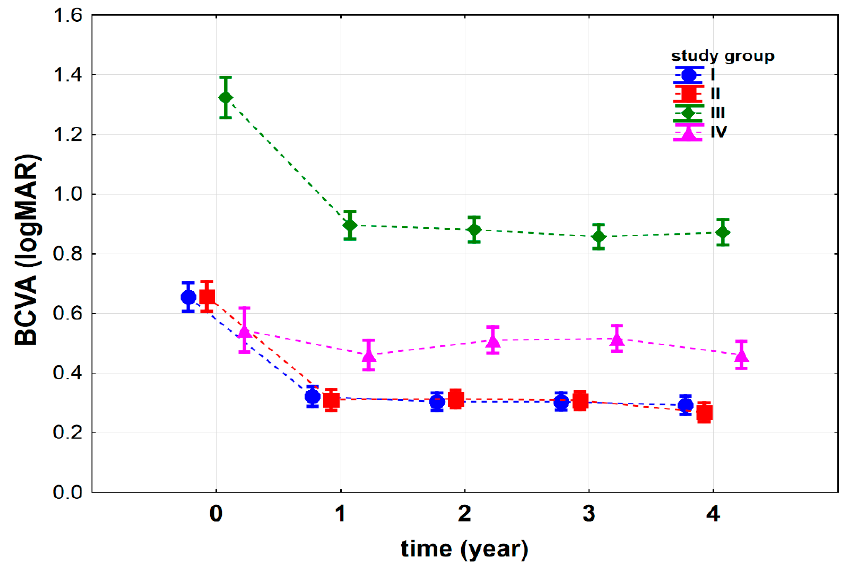
Figure 2. Best-corrected visual acuity (BCVA) (logMAR) before (t 0 ) and after iris-claw Artisan intraocular lens (IOL) implantation in four groups of patients: I—patients subjected to complicated cataract surgery, II—patients with postoperative aphakia, III—patients with aphakia subjected to penetrating keratoplasty, IV—patients subjected to pars plana vitrectomy and luxated IOL extraction. Vertical lines represent 95% confidence intervals. For the reader’s convenience, the points relating to individual groups have been joined by a dashed line.